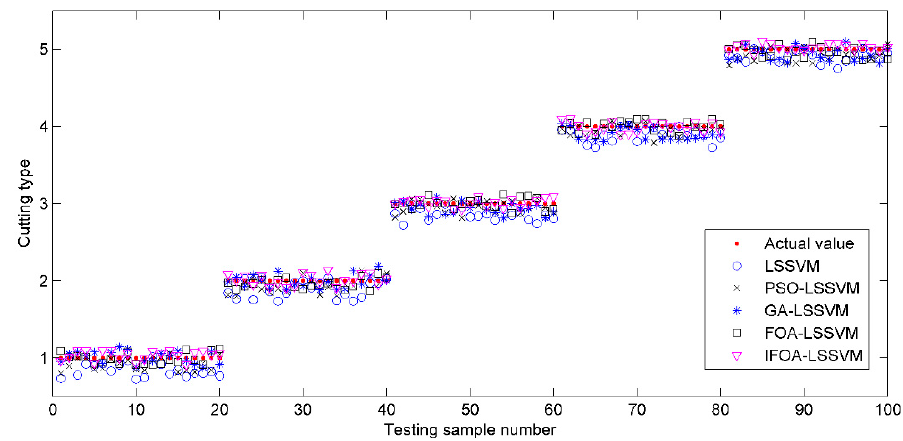
Figure 9. The prediction values of testing samples based on different models.